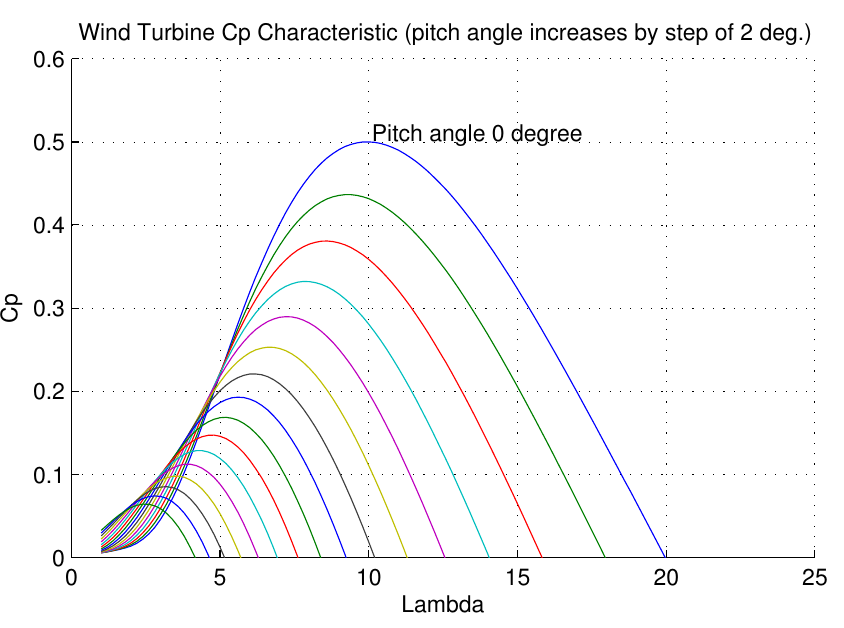
Figure 3. Turbine Power